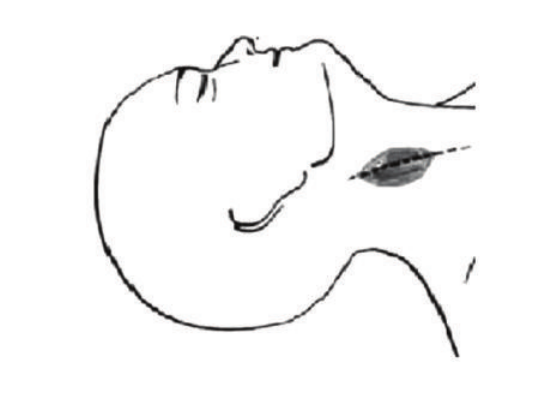
Figure 1: Skin incision and head